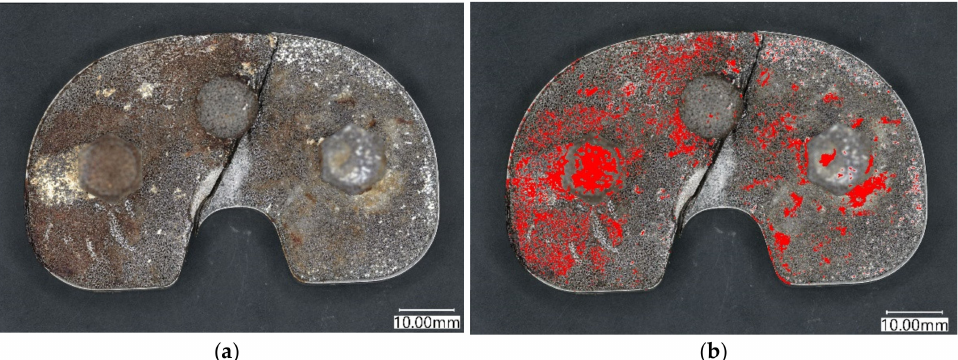
Figure 8. Light microscopy image of fractured modular tray with predominantly fibrous tissue ingrowth ( a ) converted to colour ( b ) showing bone area/pore area (bone area is shown in red). Note less dense bone ingrowth to the medial part of the modular tibial